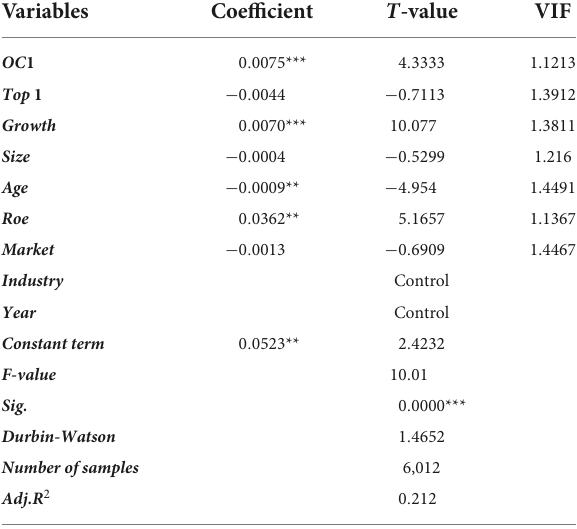
TABLE 9 Regression results of overconfidence and